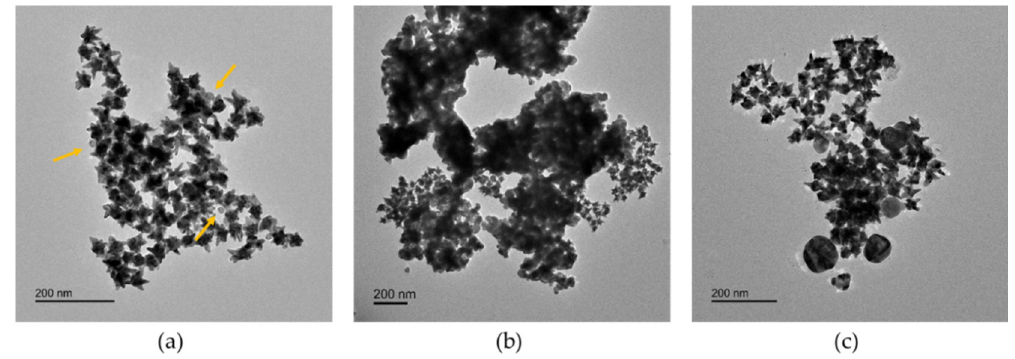
Figure 4. TEM images of AgNPs-4ABT-AuNSs interaction. ( a ) PVP-Ag15nm NPs, ( b ) PVP-Ag50–80nm NPs, and ( c ) PVP- Ag100nm NPs in ultrapure water. Scale bar of 200 nm. Yellow arrows point AgNPs.